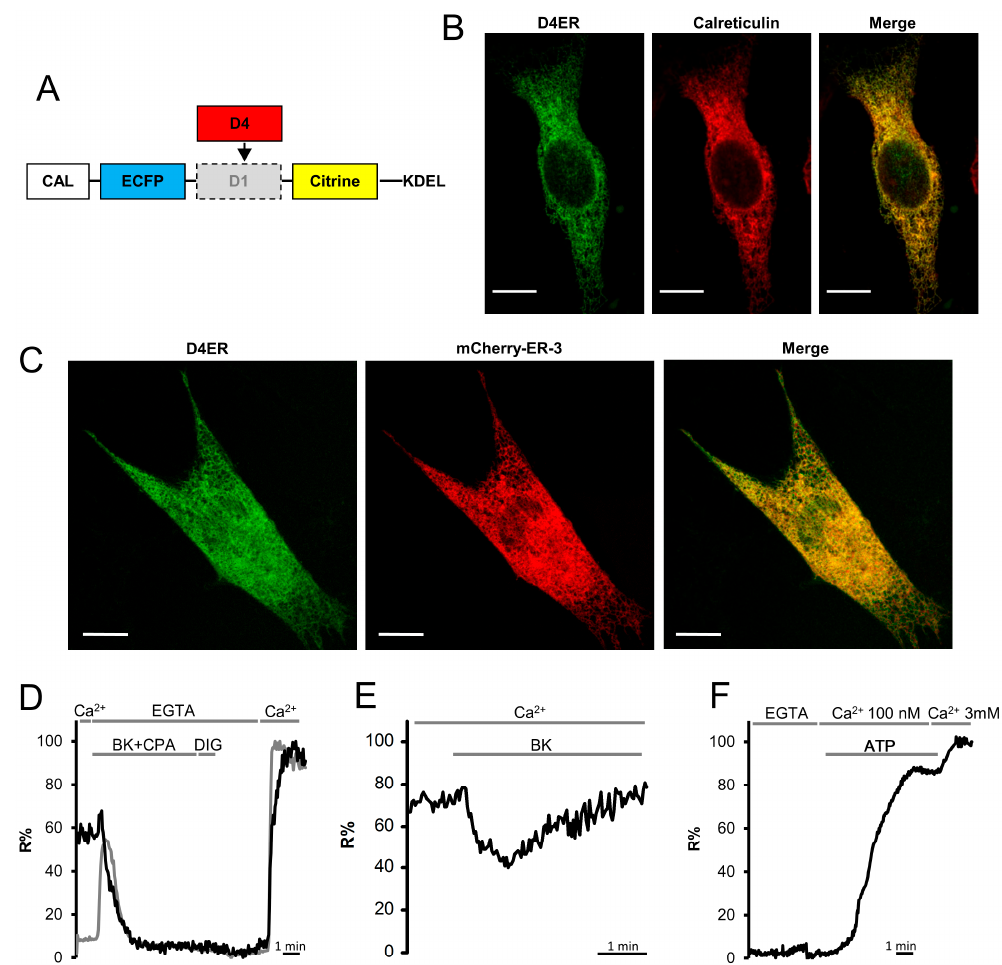
Figure 1. Generation and characterization of the ubiquitously-expressible ER-targeted probe D4ER. ( A ) Design of the construct codifying for D4ER; ( B , C ) D4ER correctly localizes in the ER; confocal images of BHK cells expressing: ( B ) the D4ER probe (green) and immuno-labelled with anti-calreticulin antibody (red); or ( C ) the D4ER probe (green) and an ER-targeted mCherry (red). Yellow colour represents the merge between the two signals coming from the protein pair. Scale bar, 10 μ m; ( D – F ) D4ER correctly monitors [Ca 2+ ] variations within the ER; ( D ) Representative kinetics of nuclear (grey) and ER (black) R% values in a single BHK cell co-expressing H2B-D3cpv and D4ER. Live cells were stimulated with BK (100 nM) plus CPA (20 μ M) in a Ca 2+ -free extracellular-like medium, then permeabilized with digitonin (DIG, 20 μ M) in an intracellular-like medium containing EGTA (600 μ M); then an intracellular-like medium containing CaCl 2 (3 mM) was perfused; ( E ) representative kinetics of ER R% values in a BHK cell expressing D4ER. Live cells were stimulated with BK (100 nM) in a Ca 2+ (1 mM)-containing extracellular-like medium; and ( F ) representative D4ER kinetic of a BHK cell pre-incubated with CPA (20 μ M) for 10 minutes in a extracellular-like Ca 2+ -free EGTA (300 μ M)-containing medium, and then permeabilized for 30 s with DIG (20 μ M) in an intracellular-like medium containing EGTA (600 μ M). The cell was washed with an intracellular-like medium containing EGTA (600 μ M) and perfused with an intracellular-like medium containing 100 nM free Ca 2+ in the presence of ATP (100 μ M). Eventually, Ca 2+ in excess (3 mM) was added. Data are plotted as R%, as defined in the Materials and Methods section.